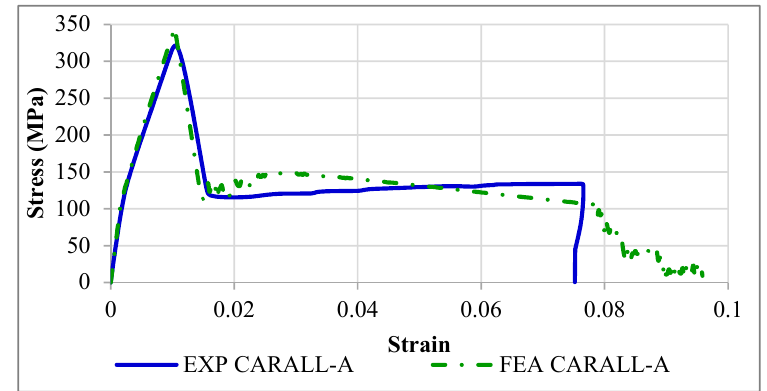
Figure 27. FEA and experimental stress-strain plots for CARALL-A specimens.